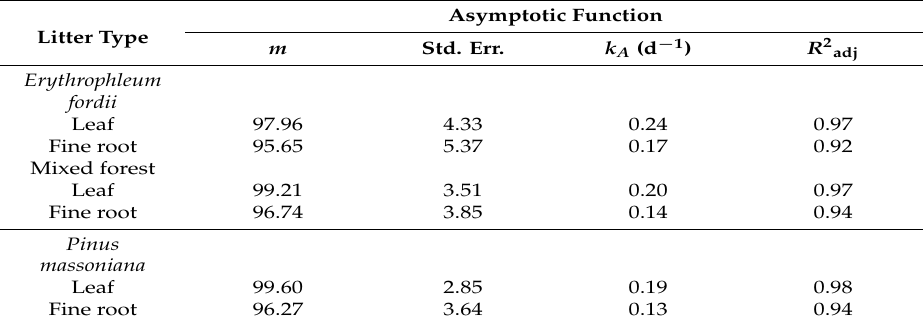
Table 2. Decomposition rate ( k A , n = 3) of leaf and fine root litter of three subtropical plantations in China.